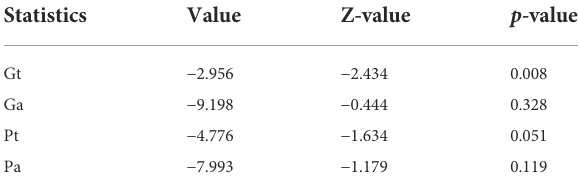
Table 5). The effect of EGR on EF is signi fi cantly positive, as